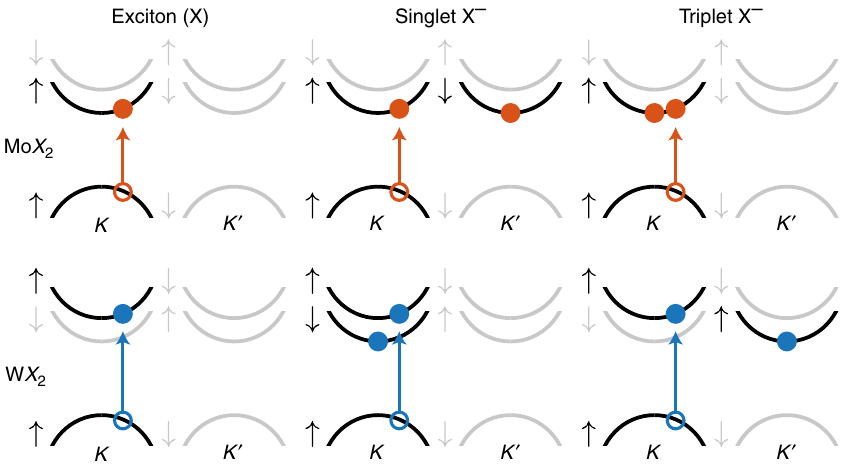
Fig. 1 Schematic illustration of the band structure and optical transitions of monolayer Mo X 2 and W X 2 . Shown are the spin-dependent band structures near the K and K ′ points, derived from fi rst-principles calculations 12 , including the (helicity-selective) optical transitions and electronic con fi gurations involved in A excitons and associated negatively charged trions (the lower spin – split valence band is not shown). Singlet trions are intervalley in Mo X in W X 2 ; the situation is reversed for triplet trions. Note that the depicted vertical transitions become mixed as a result of quasiparticle